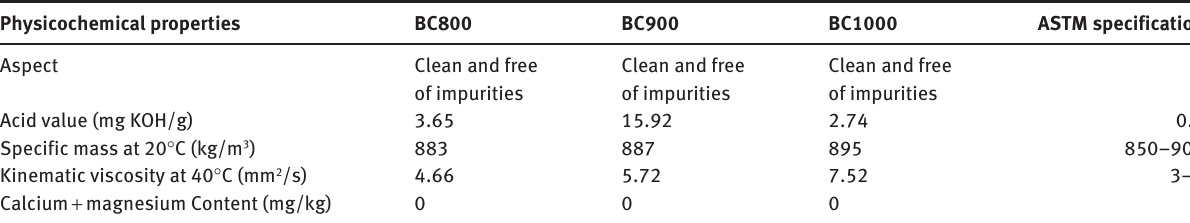
Table 2: Physical and chemical properties of different biodiesels. Physicochemical